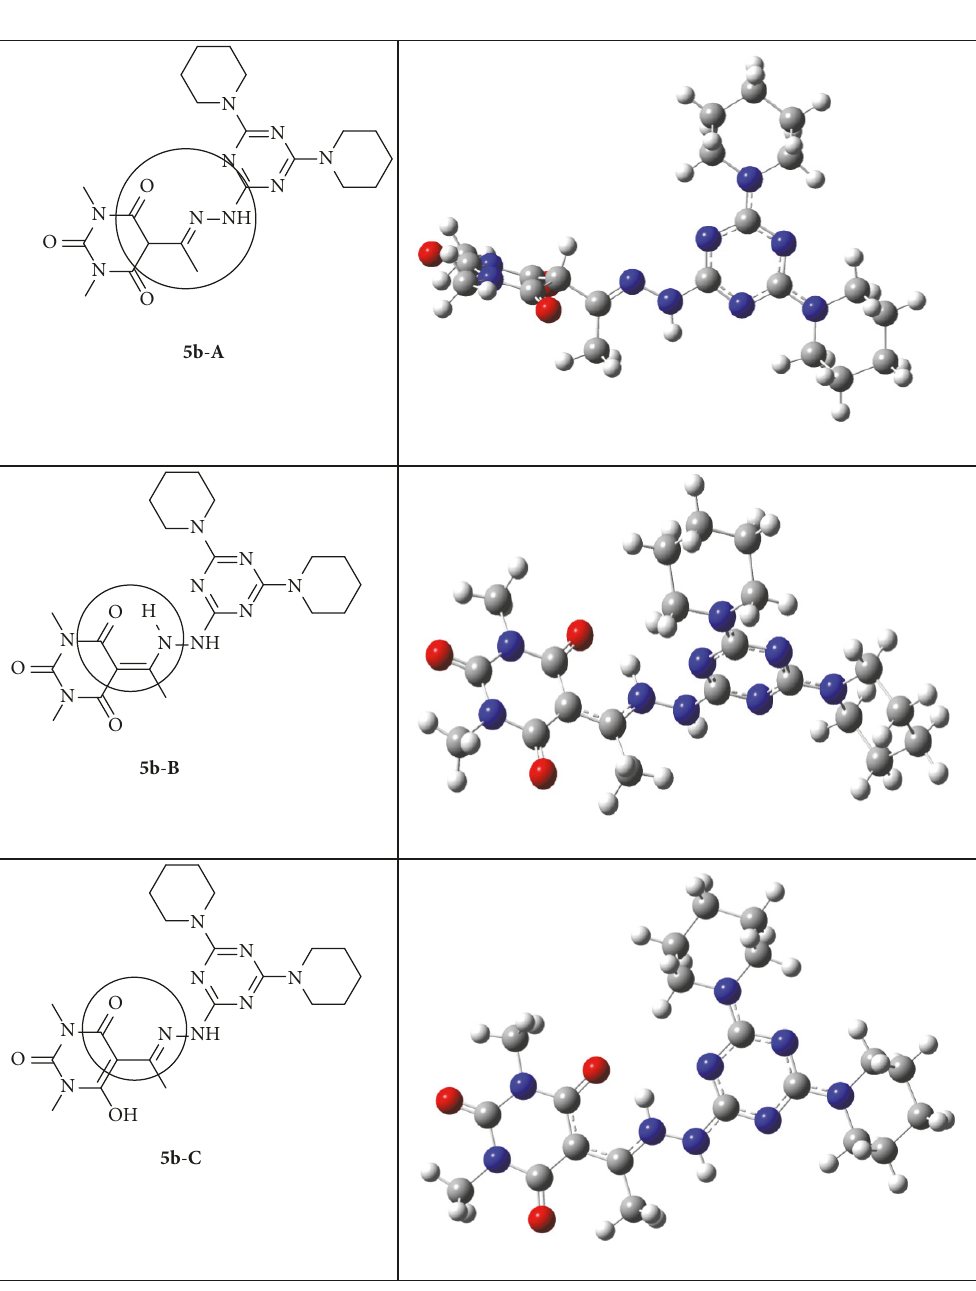
Figure 4: The expected 3D tautomeric structure of compound 5b